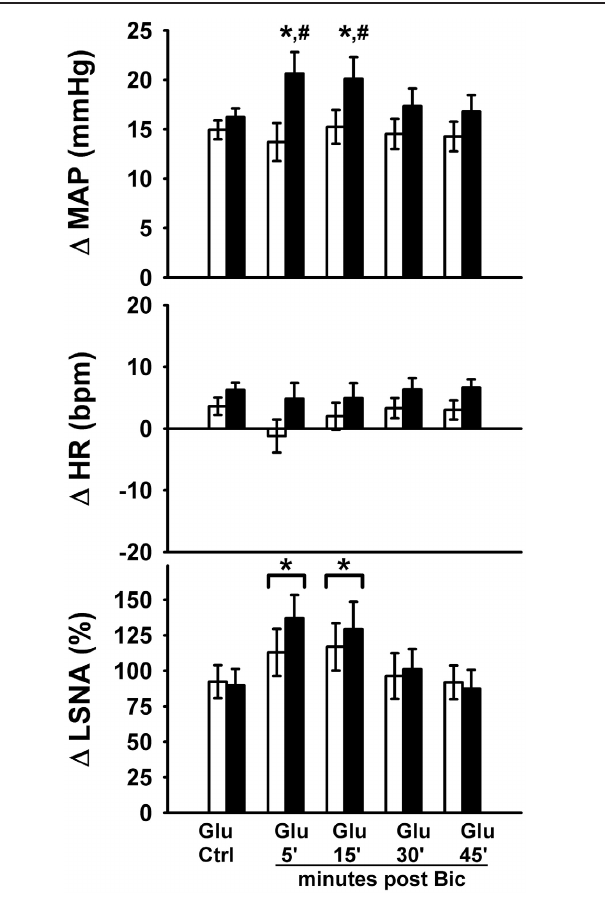
FIGURE 3 | Peak MAP, HR, and LSNA responses to activation of the rostral ventrolateral medulla with glutamate (10mM, 30nl) in the presence or absence of GABA A receptor blockade with bicuculline (5mM, 60nl). Sedentary (filled bars, n = 10) and physically active rats (open bars, n = 10) had similar pressor and sympathoexcitatory response to glutamate prior to bicuculline (Glu Ctrl). Following bicuculline, sedentary animals exhibited a selective enhancement in pressor responses to glutamate at 5 and 15min ( ∗ p < 0 . 05), resulting in significantly greater pressor responses compared to physically active animals ( # p < 0.05 at 5 and 15min). LSNA response were similarly enhanced in both groups at 5 and 15min ( ∗ with bracket, p < 0 . 05). Responses in both groups returned to control within 30min. The small HR responses were also significantly different between groups ( p < 0 . 05). Abbreviations are as defined in Figure 1